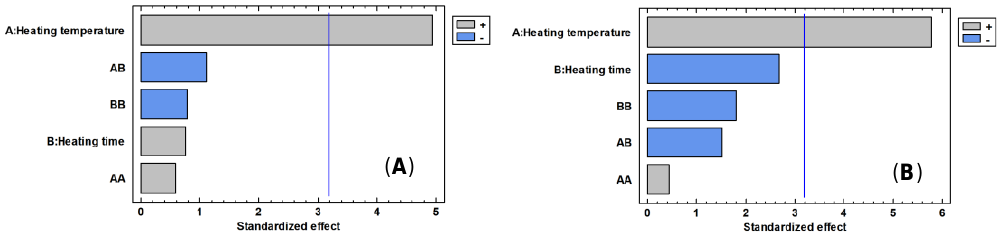
Figure 3. Pareto chart of main effects in the 3 2 factorial design for the number of chromatographic peaks ( A ) and total area ( B ).